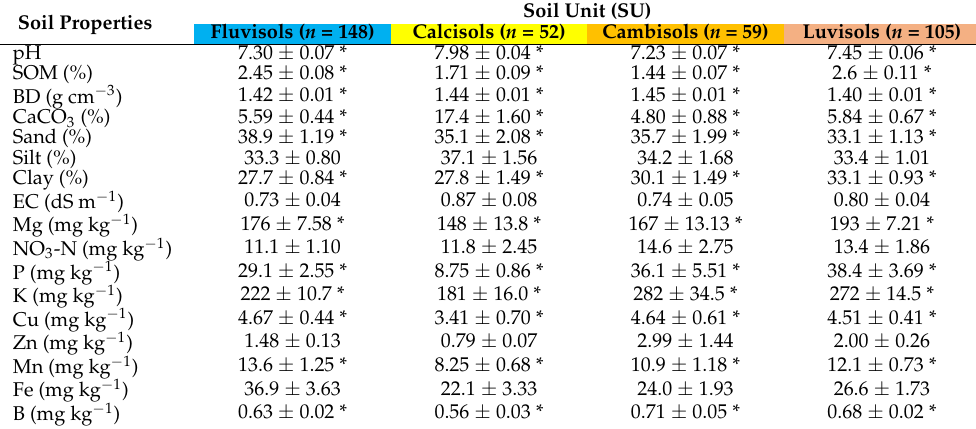
Table 6. Least square means with standard error (SE) of soil chemical and physical parameters in different soil units